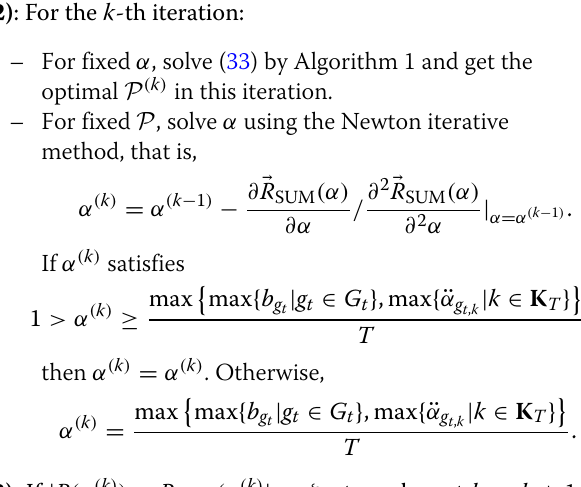
Algorithm 2 Solving problem (32):